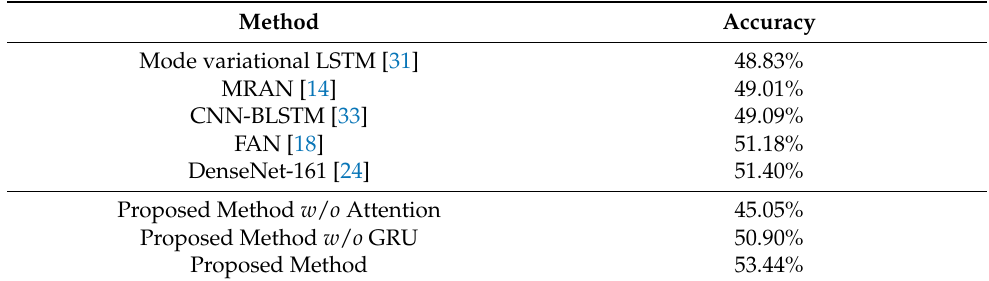
Table 2. Comparison of methods on the AFEW (Acted Facial Expressions in the wild)